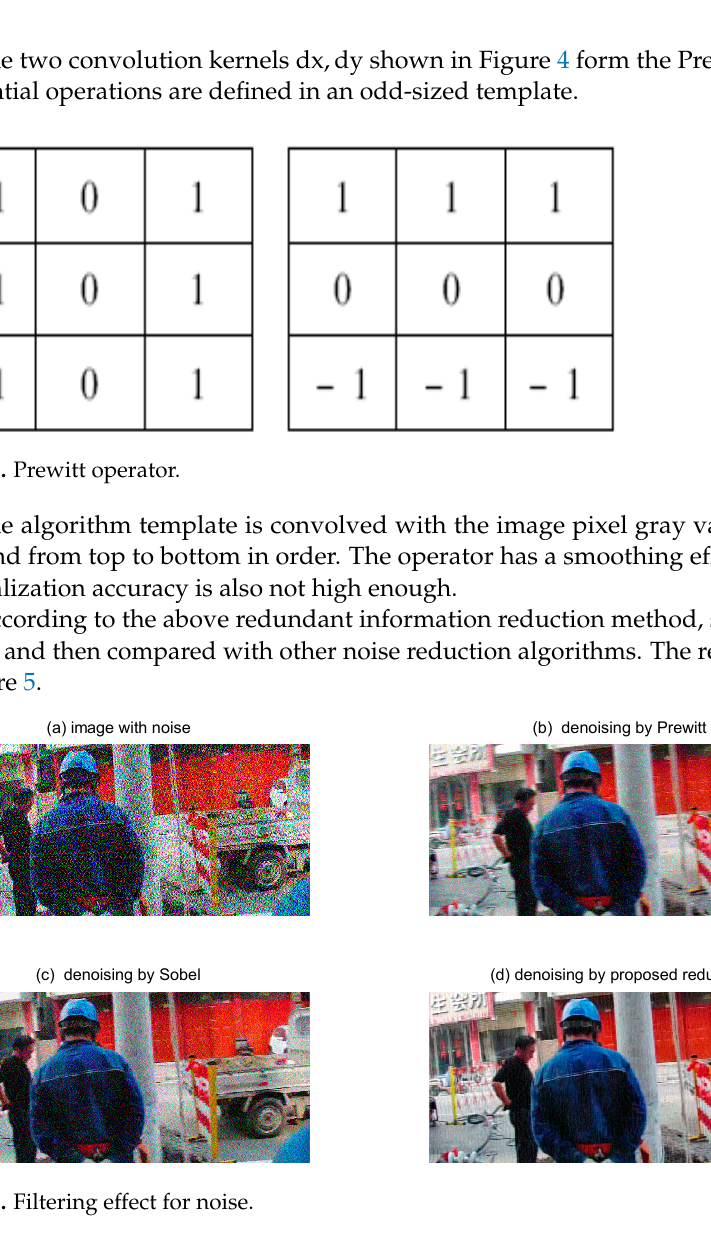
Figure 3. Sobel operator.